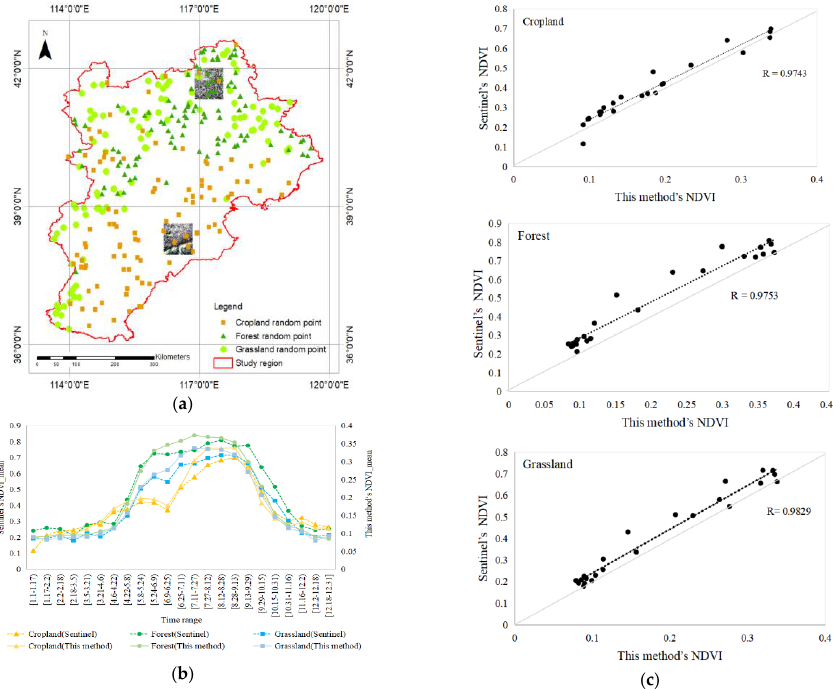
Figure 6. Validation of random point and true-color image distribution and comparison of the mean NDVI statistical analysis for the method in this paper and Sentinel. ( a ) Validation of random point and true-color image distribution. ( b ) Change in the mean value of NDVI. ( c ) Comparison of this